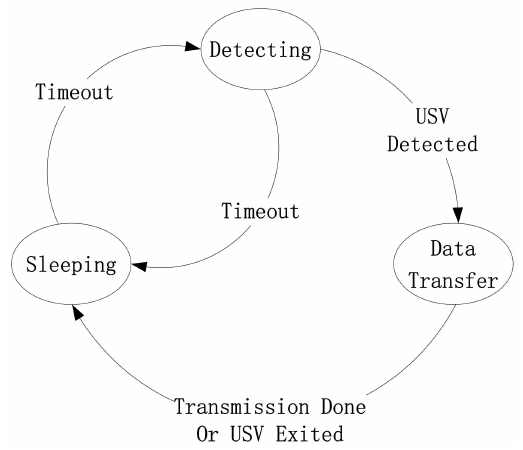
Figure 3. Diagram of node state